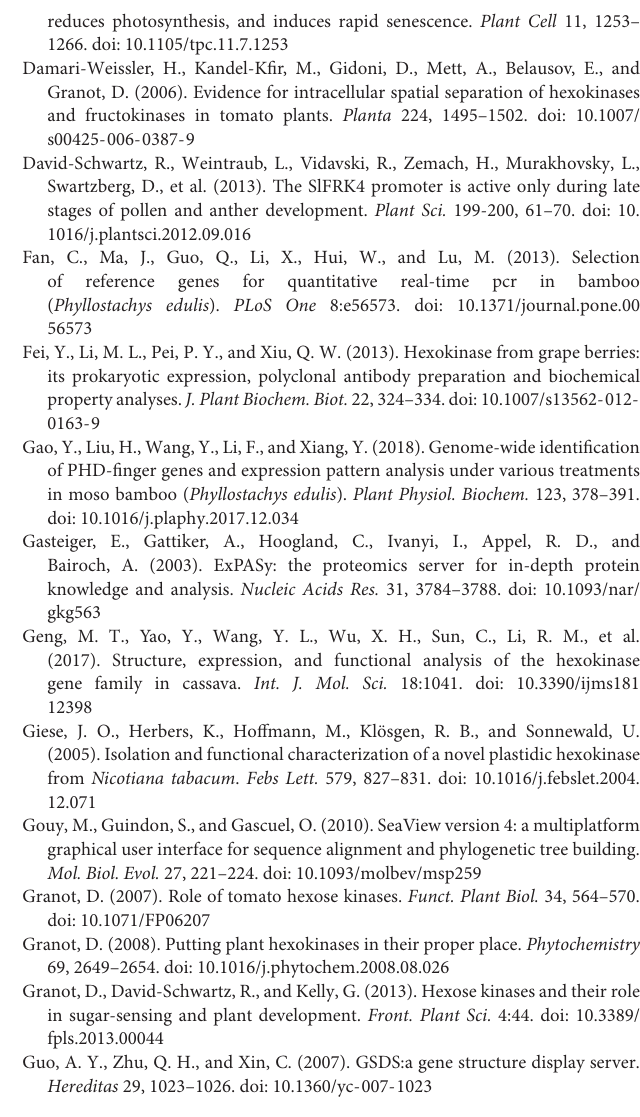
FIGURE S2 | The chromosomal distribution of PeHXK genes. TABLE S1 | List of genes used in this study. TABLE S2 | Primers used in this study. FILE S1 | Genomic sequences of PeHXK